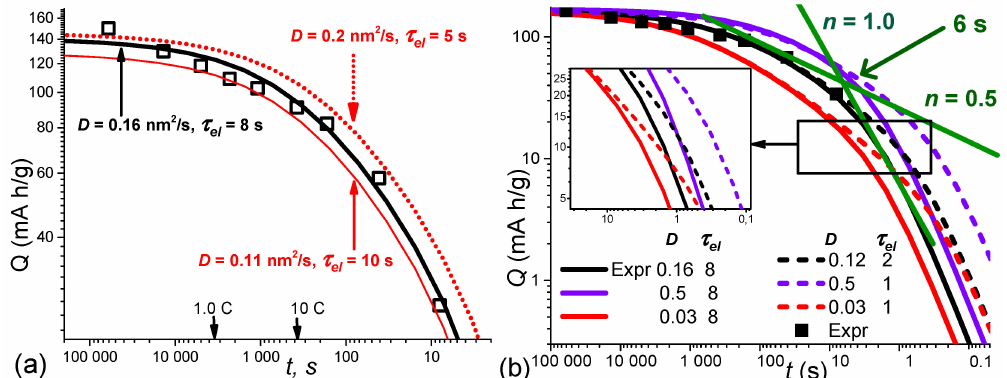
Figure 7. Cathode equivalent circuit of a crystallite column consisting of a capacitor C1 and Warburg element W1 series connection.